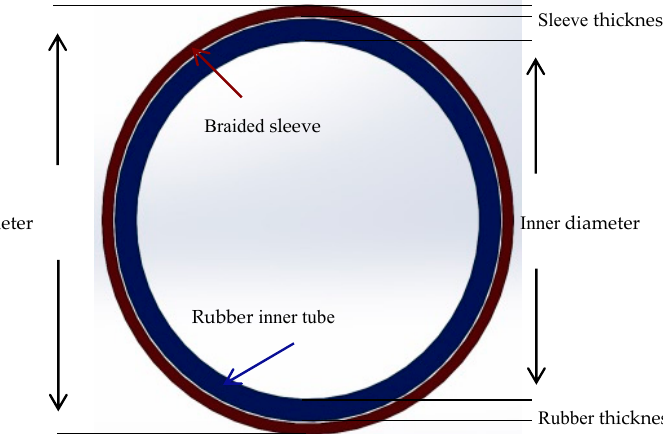
Figure 5. The cross-section of the PMA structure.